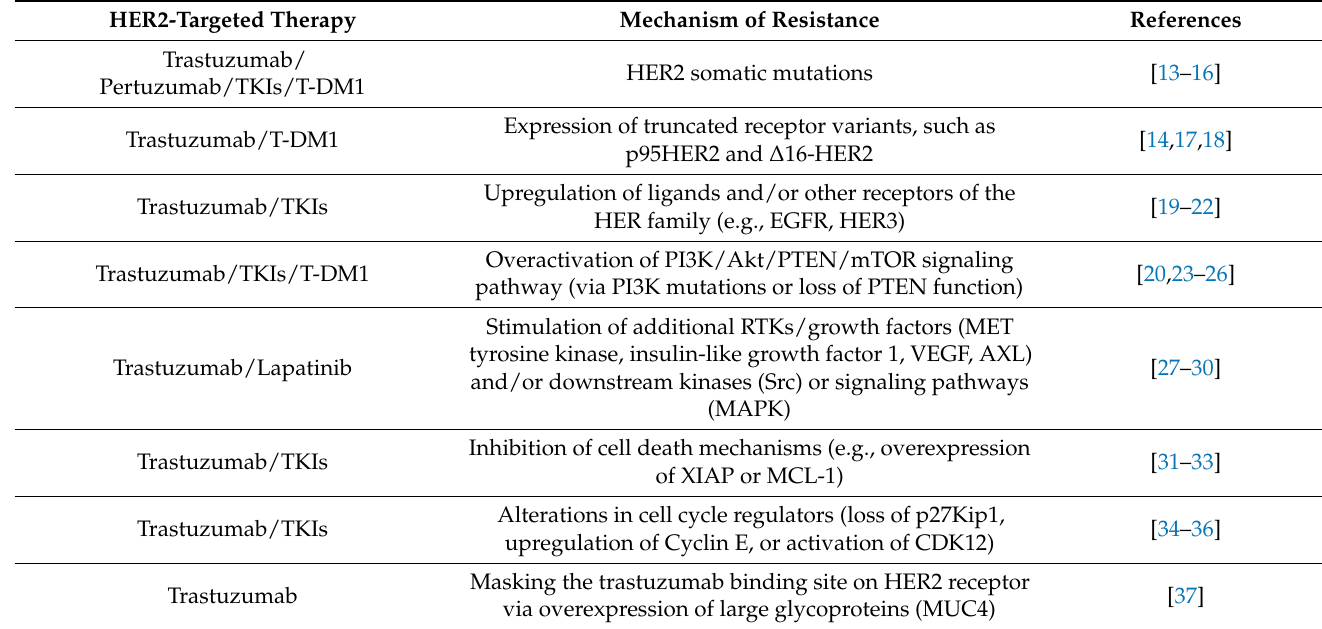
Table 1. Previously described mechanisms of resistance to anti-HER2